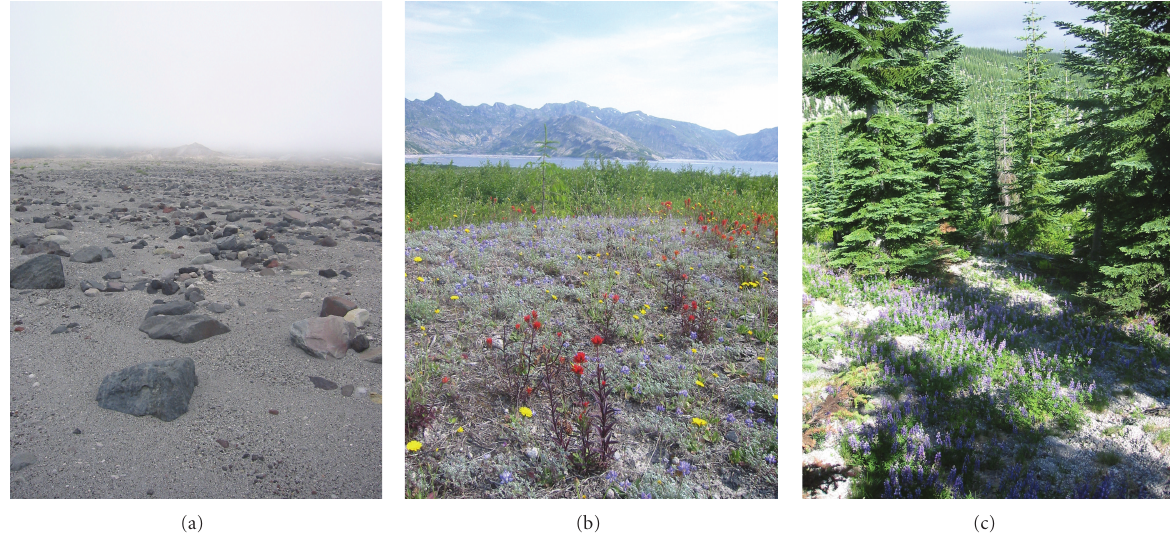
Figure 1: Representative photographs of (a) Pumice Plain-Low Vegetation (PPLV) habitat type, (b) Pumice Plain-High Vegetation (PPHV) habitat type, and (c) Blowdown Zone (BDZ) habitat type, where ants were collected at Mount St. Helens National Volcanic Monument. Images were taken between 22 and 25 of July 2008.